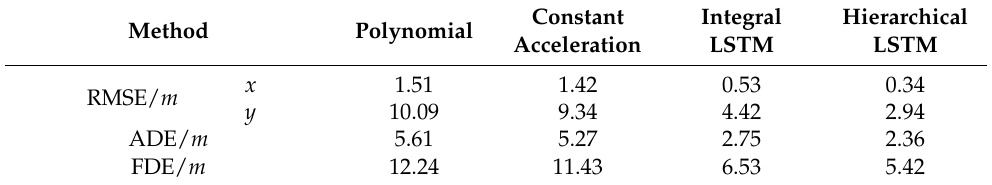
Figure 6. Comparison of prediction results of different methods. Table 2. Comparison of RMSE, ADE, and FDE of different methods over a 5-second prediction